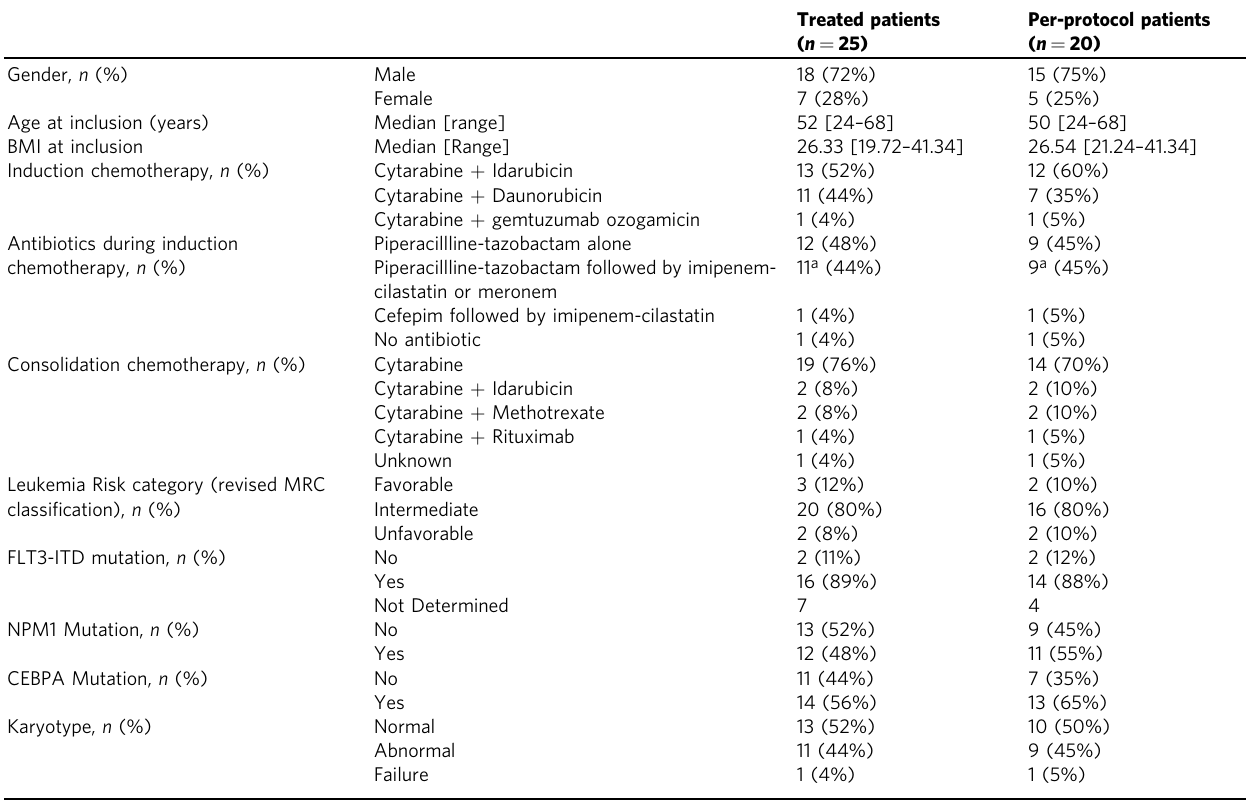
Treated patients ( n = 25)